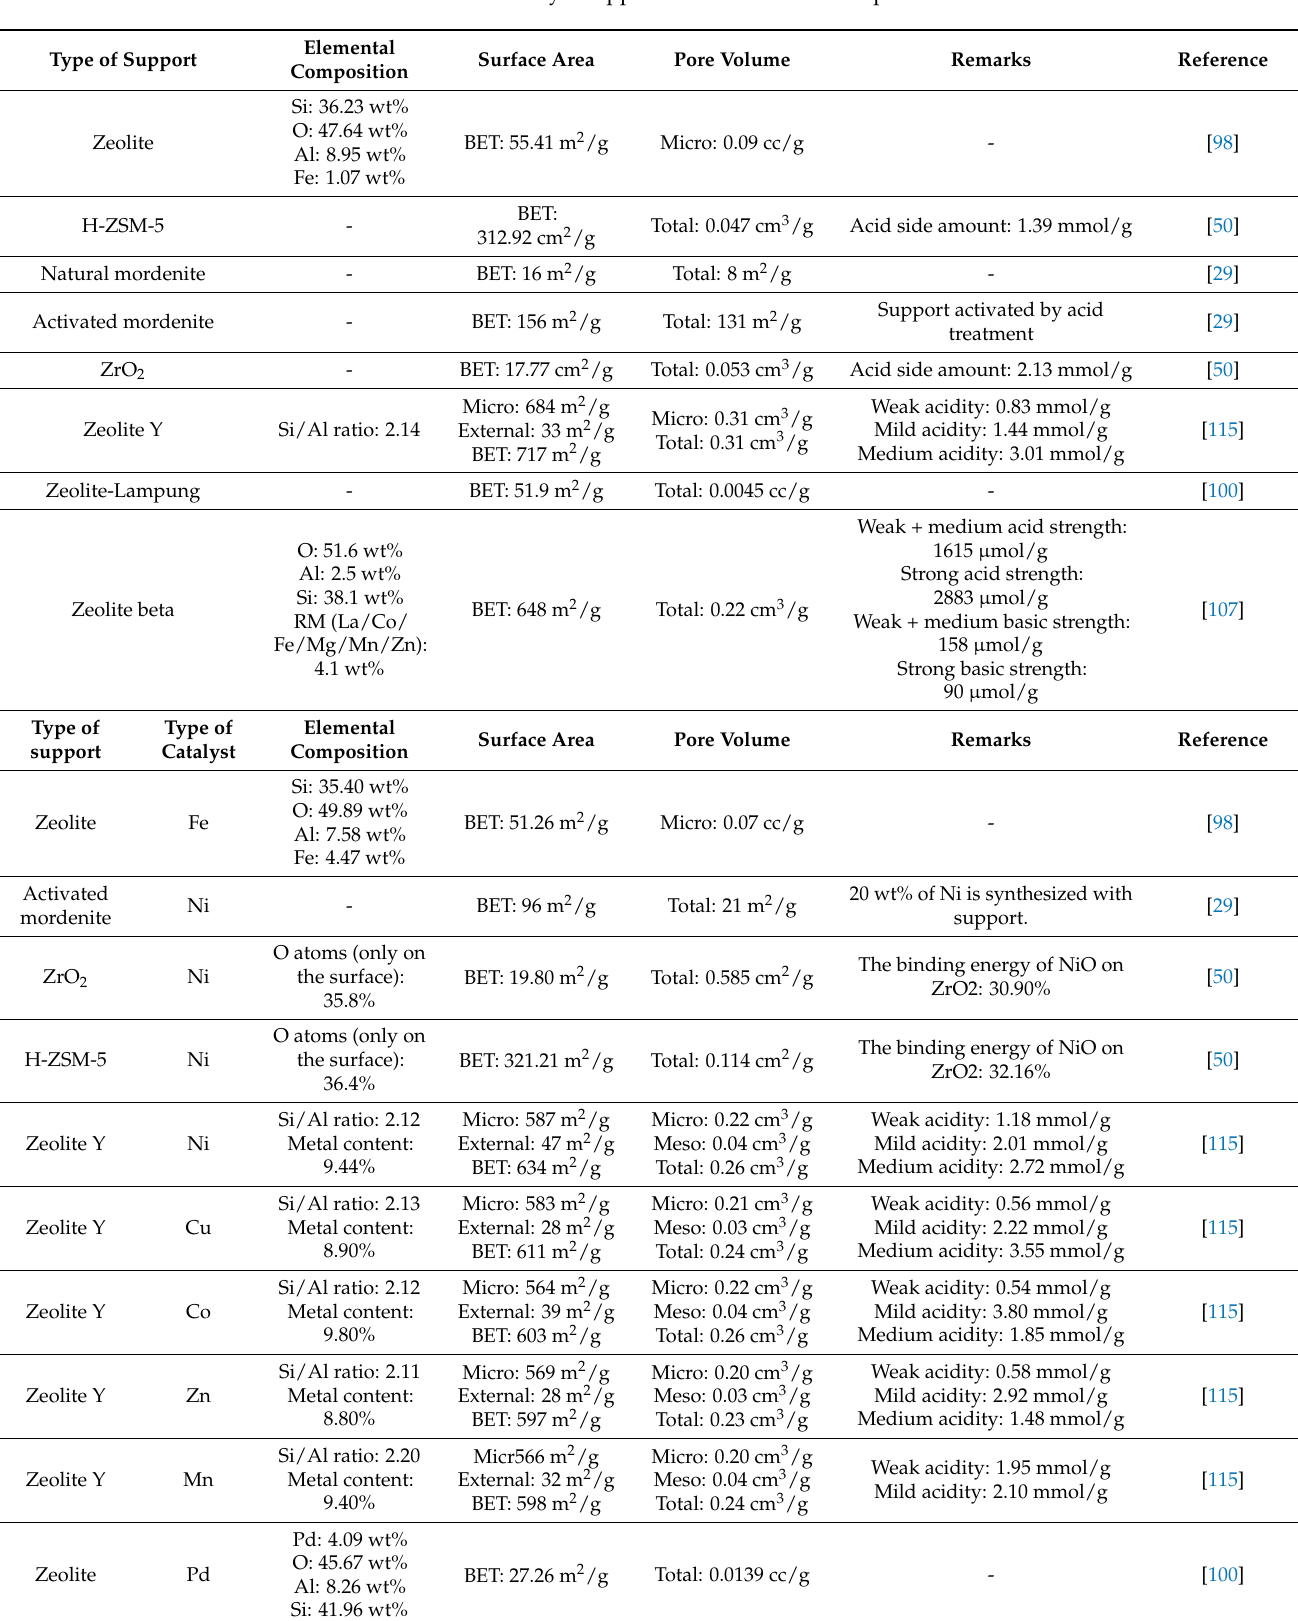
Table 4. Zeolite as catalyst support for renewable diesel